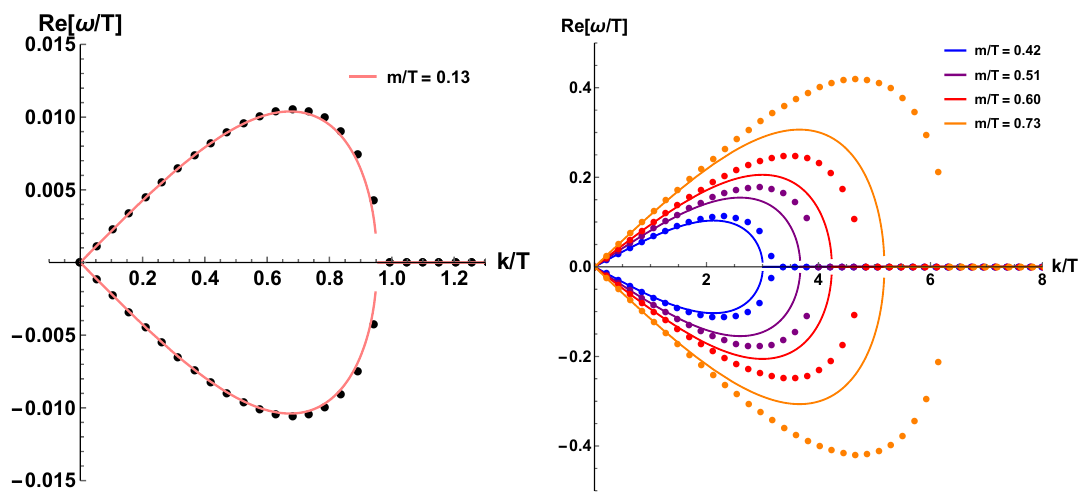
Figure 3 . The transverse phonons dispersion relation. The dots are the numerical value extracted from the QNMs spectrum and the lines are the hydrodynamic formula (3.2). Di(cid:11)erent colors represent di(cid:11)erent values of the dimensionless ratio m=T controlling the SSB of translations. The potential is chosen as V ( X ) = X 5 but the result are analogous for all N > 5 =